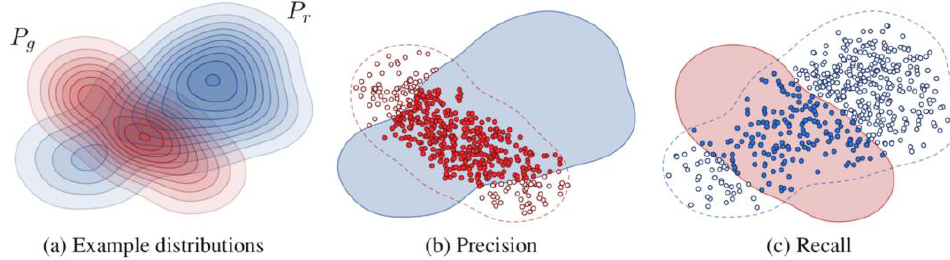
Figure 9. Illustration of precision and recall for distributions, reprinted with permission from Ref. [50], 2019, Kynkäänniemi et al. ( a ) The distribution of real images ( P r ) and the distribution of generated images ( P g ). ( b ) Precision is defined as the probability of a randomly selected image from P g being encompassed by the scope of P r . ( c ) Recall is defined as the probability of a randomly selected image from P r being encompassed by the scope of P g .